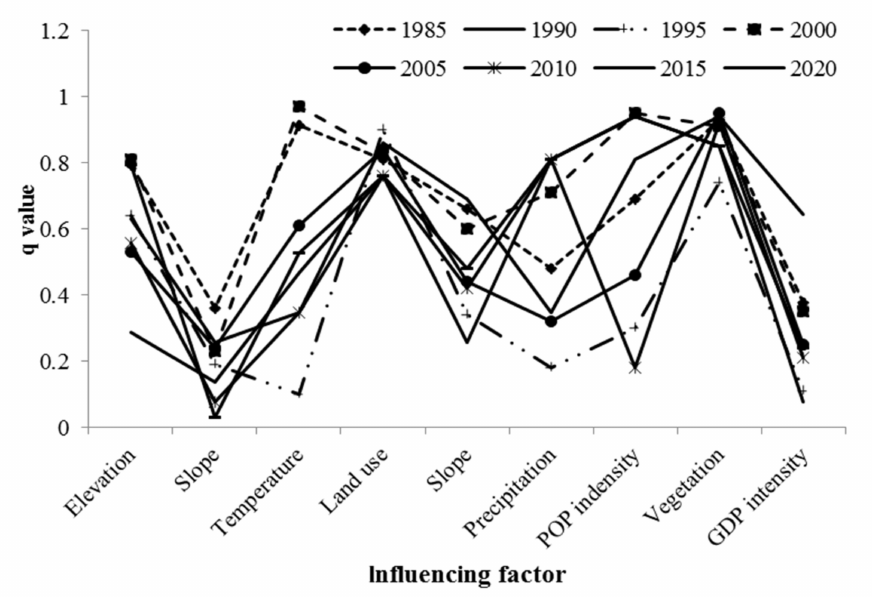
Figure 11. The dominant single factors in different historical